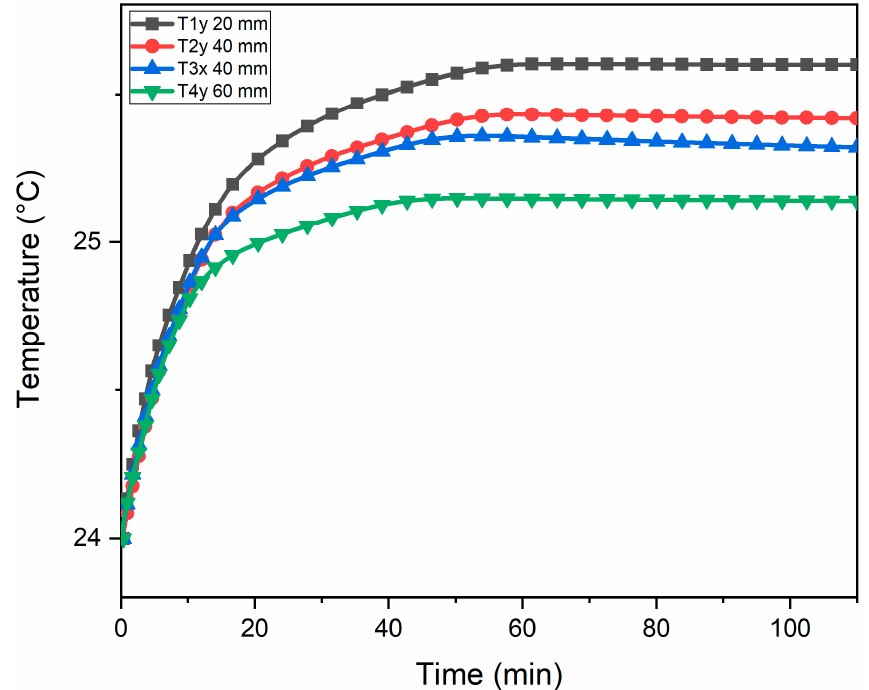
Figure 13. Temperature profile along the x- and y-axis for axial flow configuration with power input of 10 W.